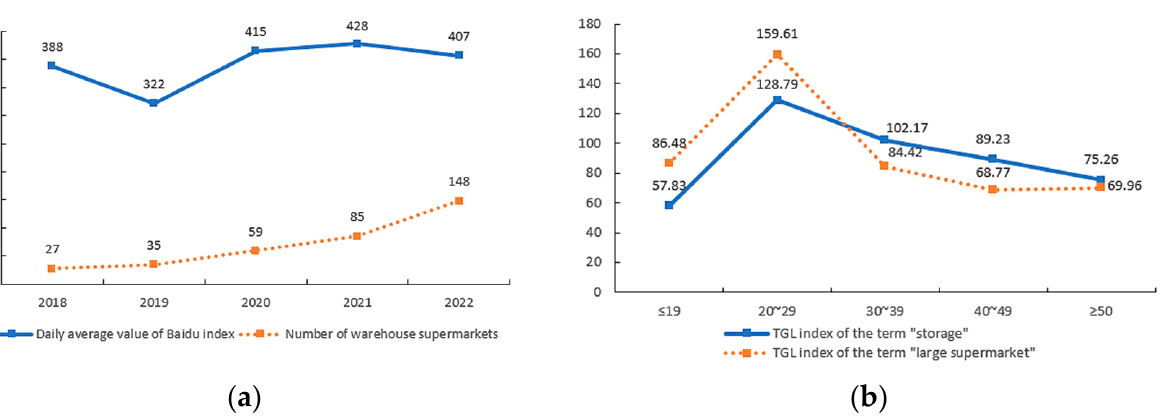
Figure 4. Trend chart of daily average search value and TGL index of relevant terms from 2018 to 2022. ( a ) The daily average search value of relevant terms in 2018–2022. ( b ) The trend chart of TGL index from 2018 to 2022.